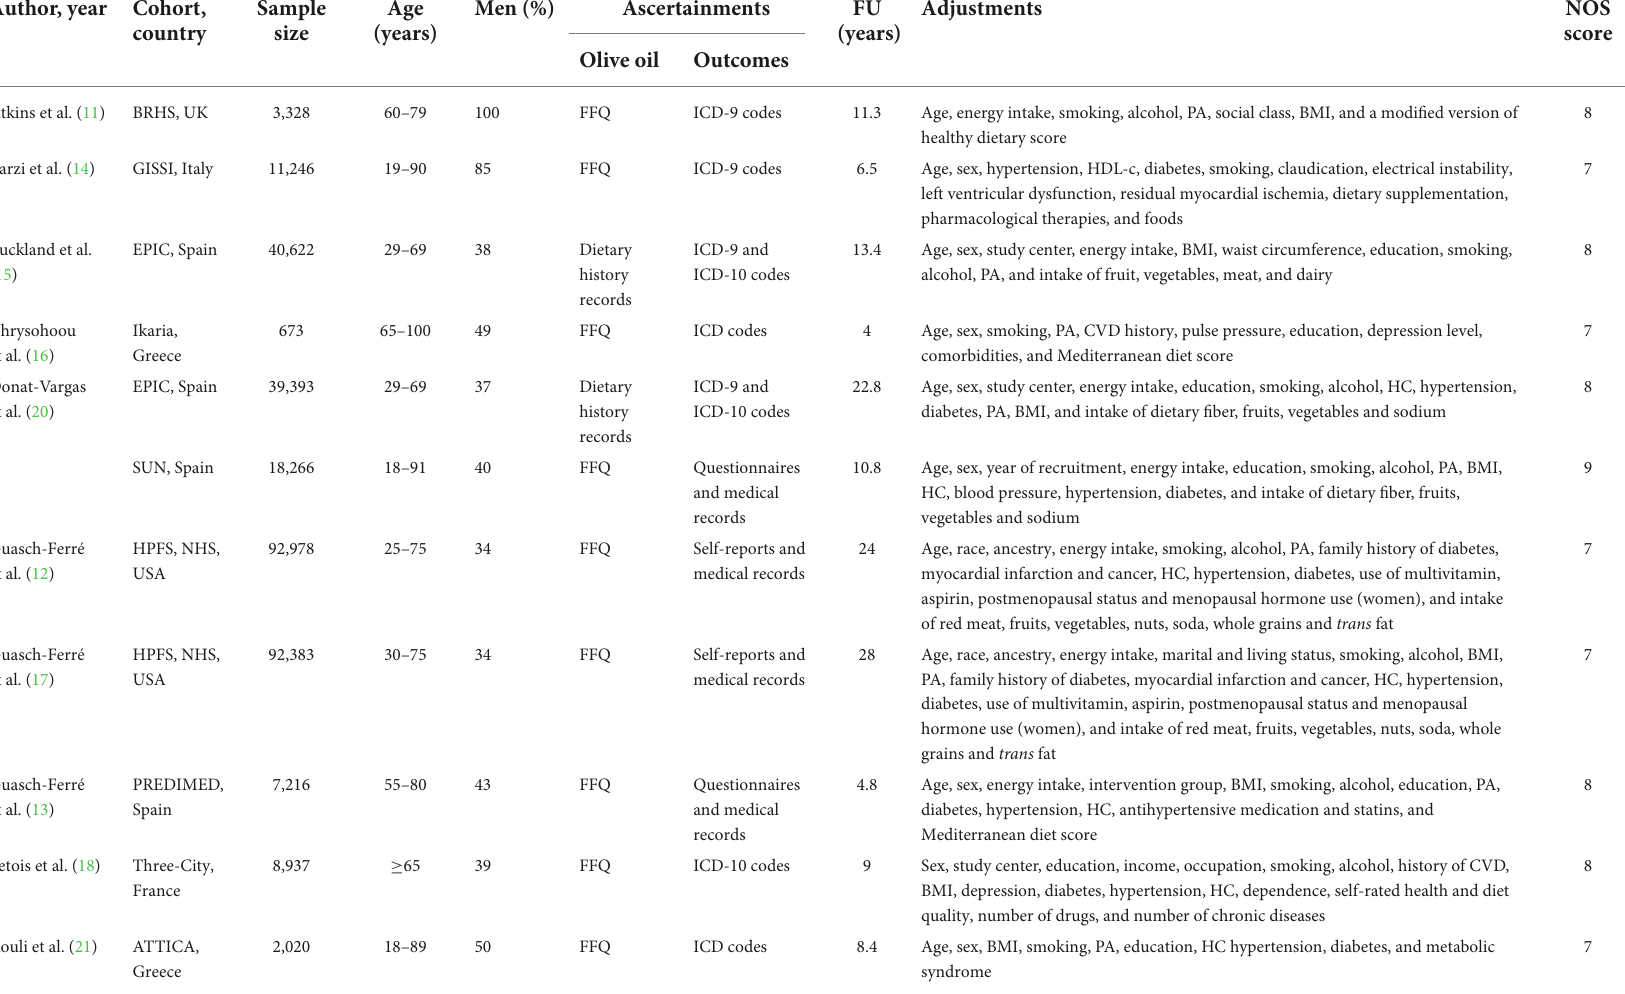
TABLE 1 General characteristics of the included cohort